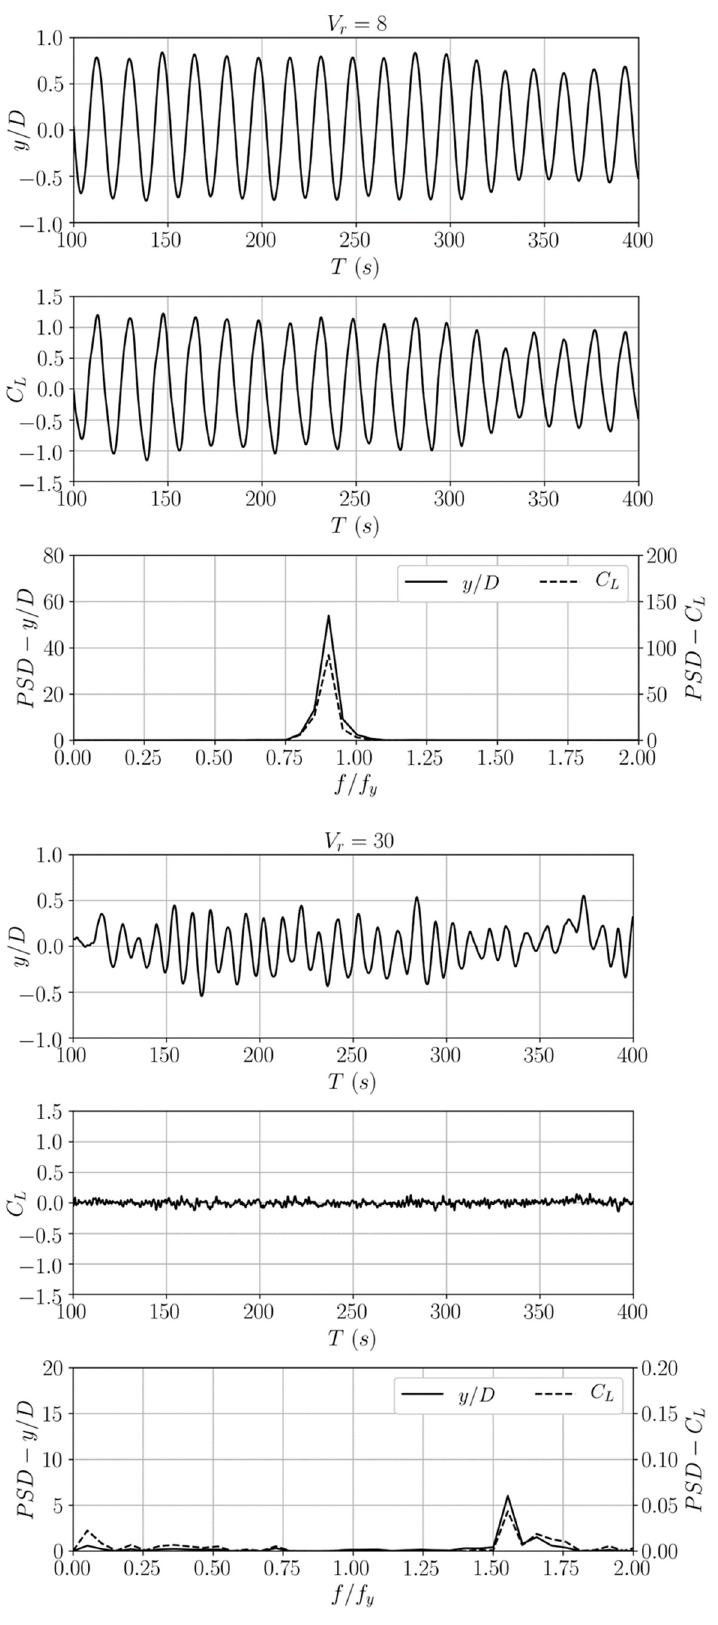
Figure 11. Time series and PSD of transverse response and force coefficient of FOWT platform with α = 90 ◦ , at various V r